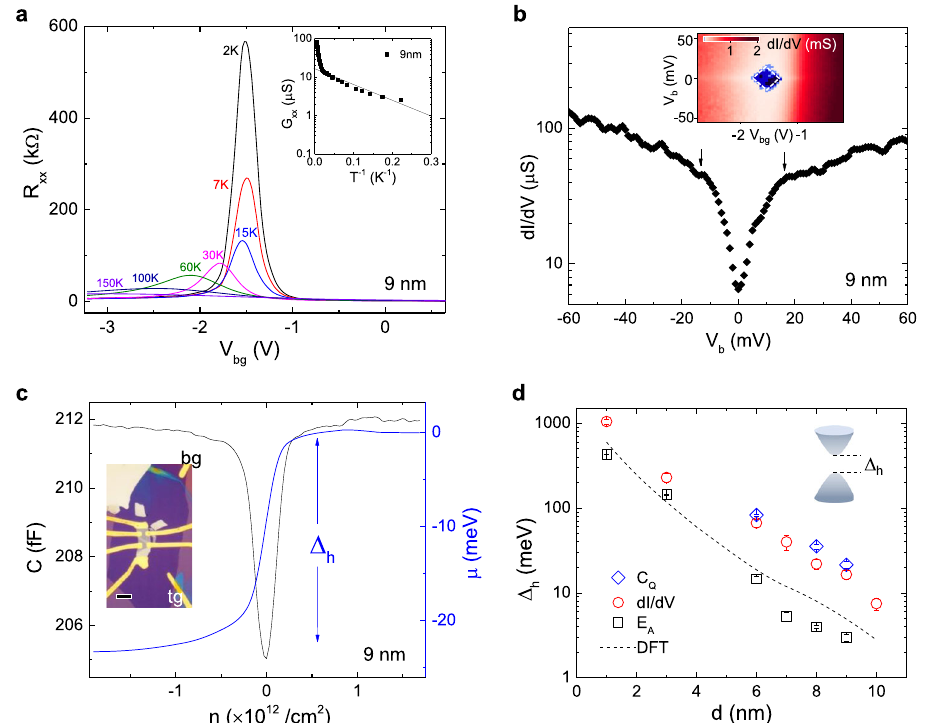
Fig.2|Probinghybridizationgap.a R xx versus V bg plotsatdifferenttemperatures. Inset in ( a ) is an Arrhenius plot of G xx versus T − 1 for V bg fi xed at the CNP. b d I /d V versus V b curveatinsulating region( V bg ~ − 1.5V).Insetin( b )isacolormapof d I /d V asfunctionsof bias voltage ( V b ) and V bg . c C and μ ( n ) asa functionof n inducedby V bg with V tg fi xed at the overall CNP. The data in ( a – c ) were collected on the same 9nm hBSTS device. Inset in ( c ) is an optical image of an 8nm hBSTS vdW